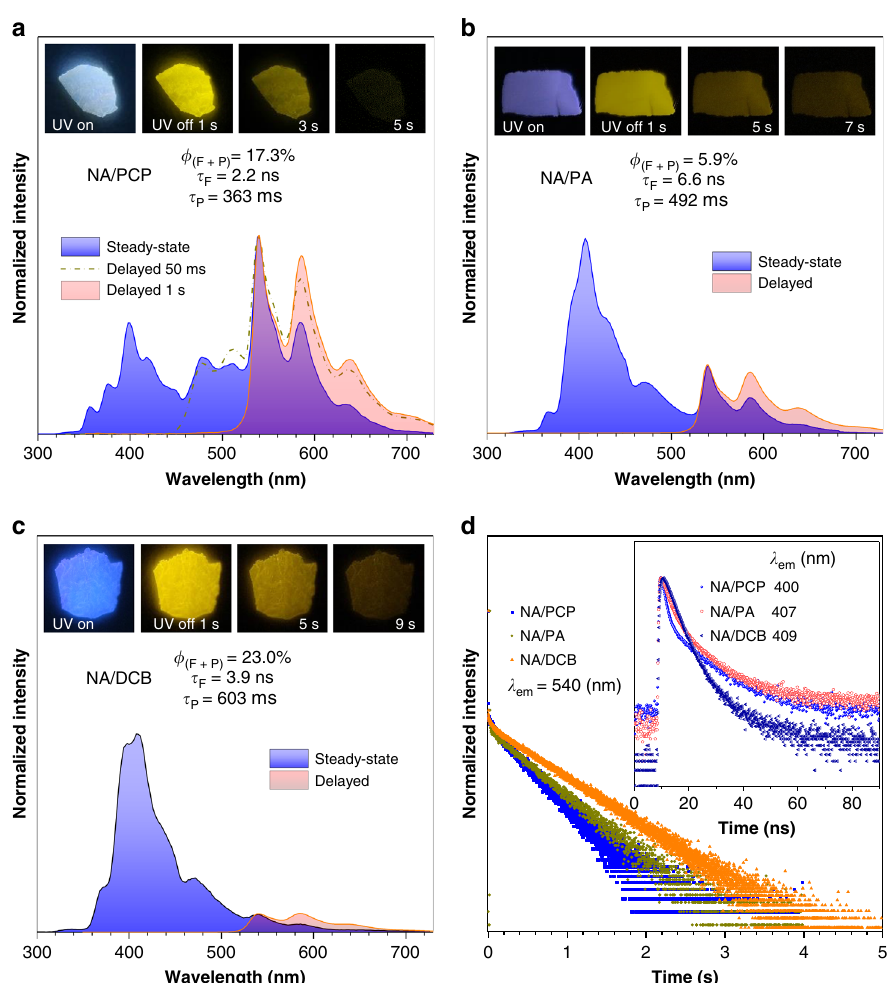
Fig. 3 Photoluminescence (PL) properties of the guest/host system. a Steady-state and delayed PL spectra of NA/PCP ( λ ex = 254 nm) at ambient conditions. Insert: photos of NA/PCP under 254 nm UV light irradiation and after UV irradiation ceased for different times. b , c are the same as ( a ) except that NA/PA and NA/DCB were used, respectively, instead of NA/PCP. For delayed spectra in ( b , c ), Δ t = 50 ms. d Time-resolved decay curves of NA/ PCP, NA/PA, and NA/DCB at maximum phosphorescence emission ( λ ex = 254 nm) and at maximum fl uorescence emission (insert, λ ex = 280 nm) at ambient conditions. NA/PCP, NA/PA and NA/DCB were obtained using a melt-casting method with a starting mass ratio of NA: PCP = NA: PA = NA: DCB = 1:100, respectively. Melt-casting: heat up to the melting point ( T m ) of the host to dissolve NA as colorless and clear solution, then cool to room temperature quickly. T m(PCP) = 126 °C; T m(PA) = 131 °C; T m(DCB) = 139 °C. ϕ (F + P) : overall quantum yield; τ F : fl uorescence lifetime; τ P :